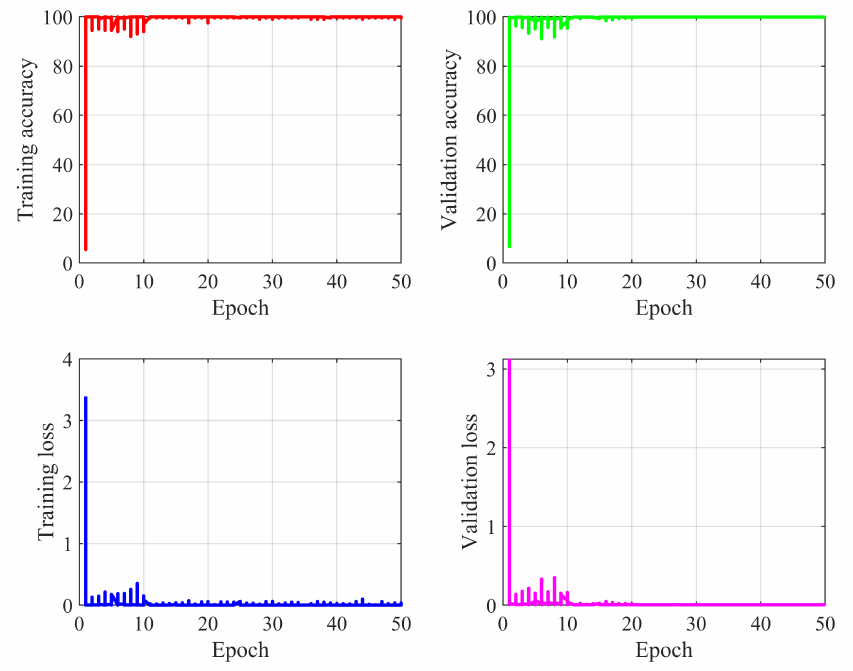
Figure 4. Proposed Demod-CNN model training and validation progress for 50